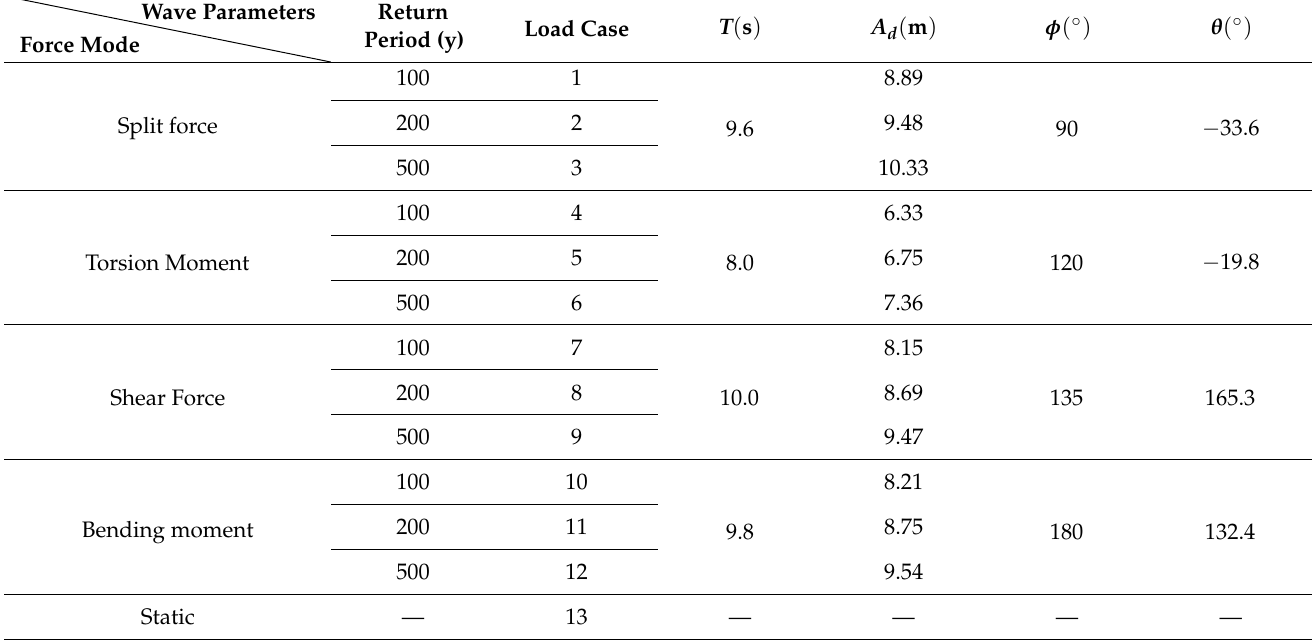
Table 5. Characteristic wave parameters for different return periods.